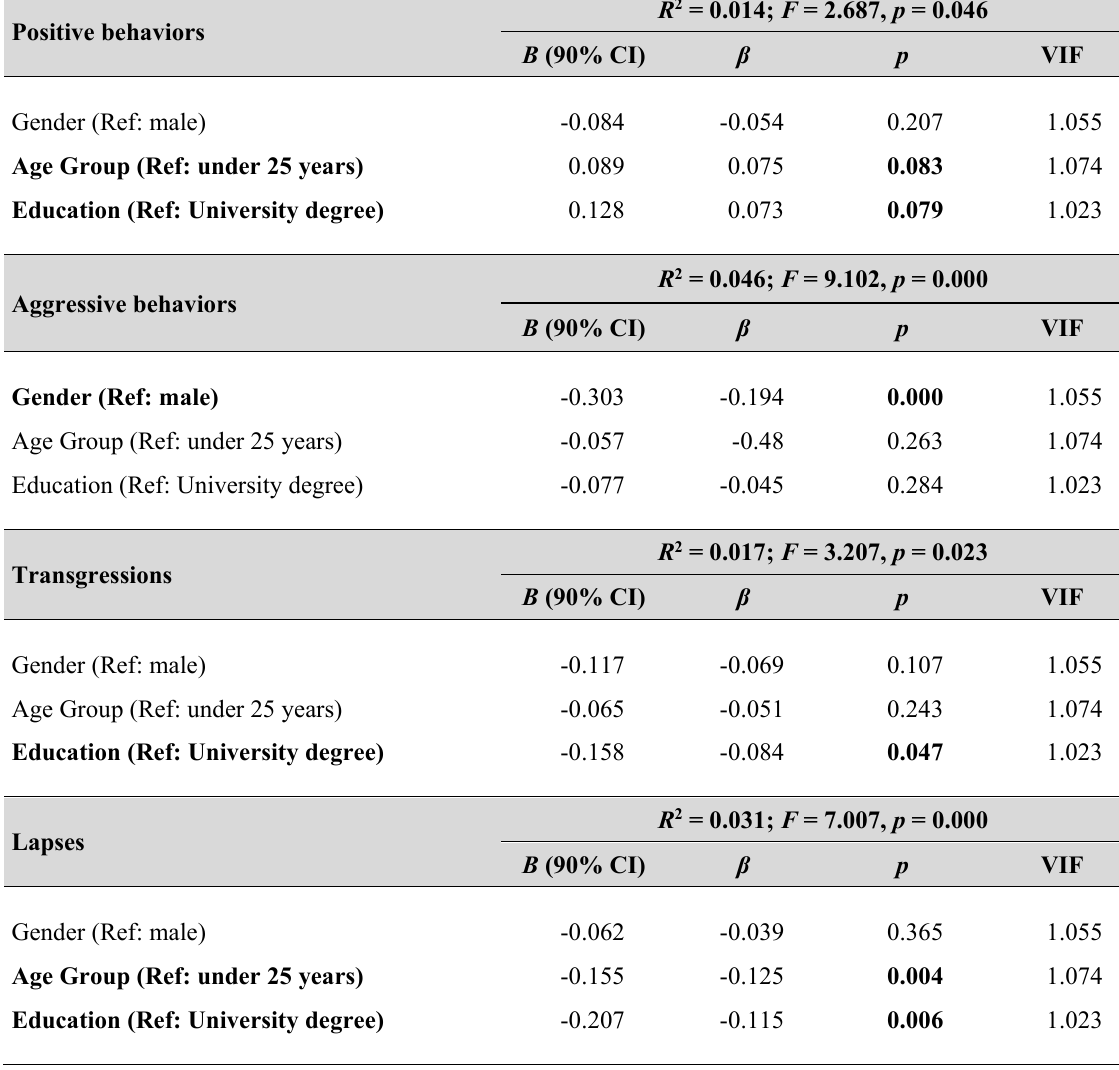
Table 5 Linear regression